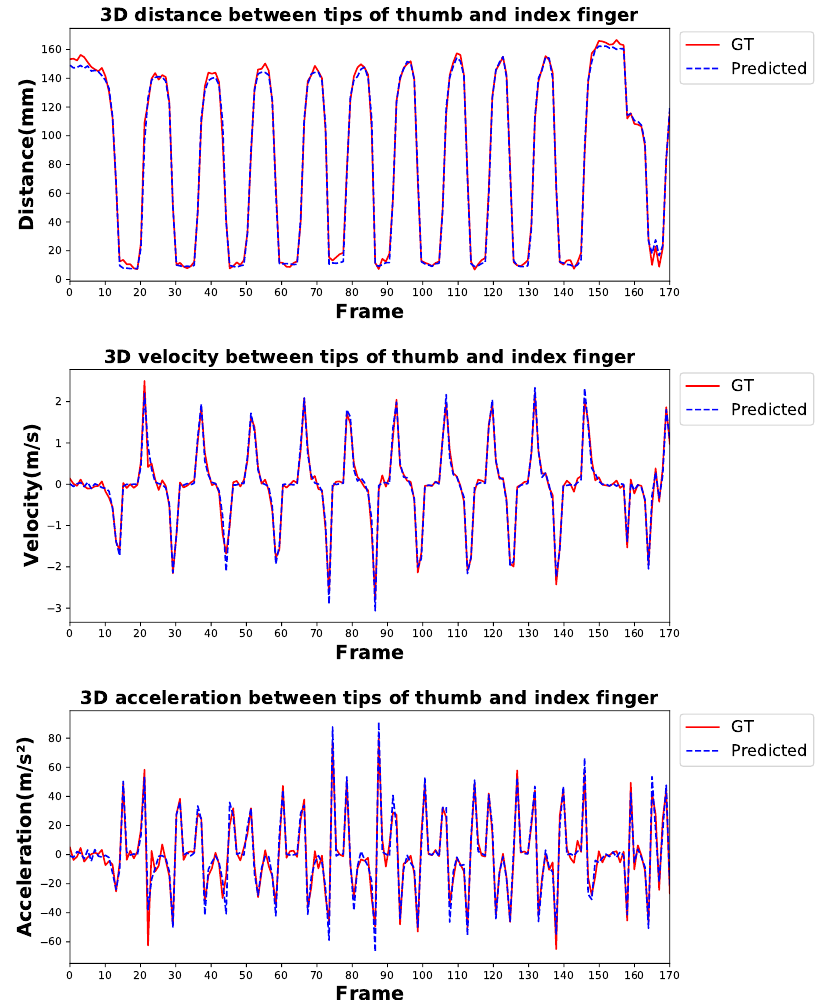
Figure 12. Qualitative result comparison between ground truth and predicted tapping distance, velocity, and acceleration during a trial of the finger tapping test. GT denotes the ground